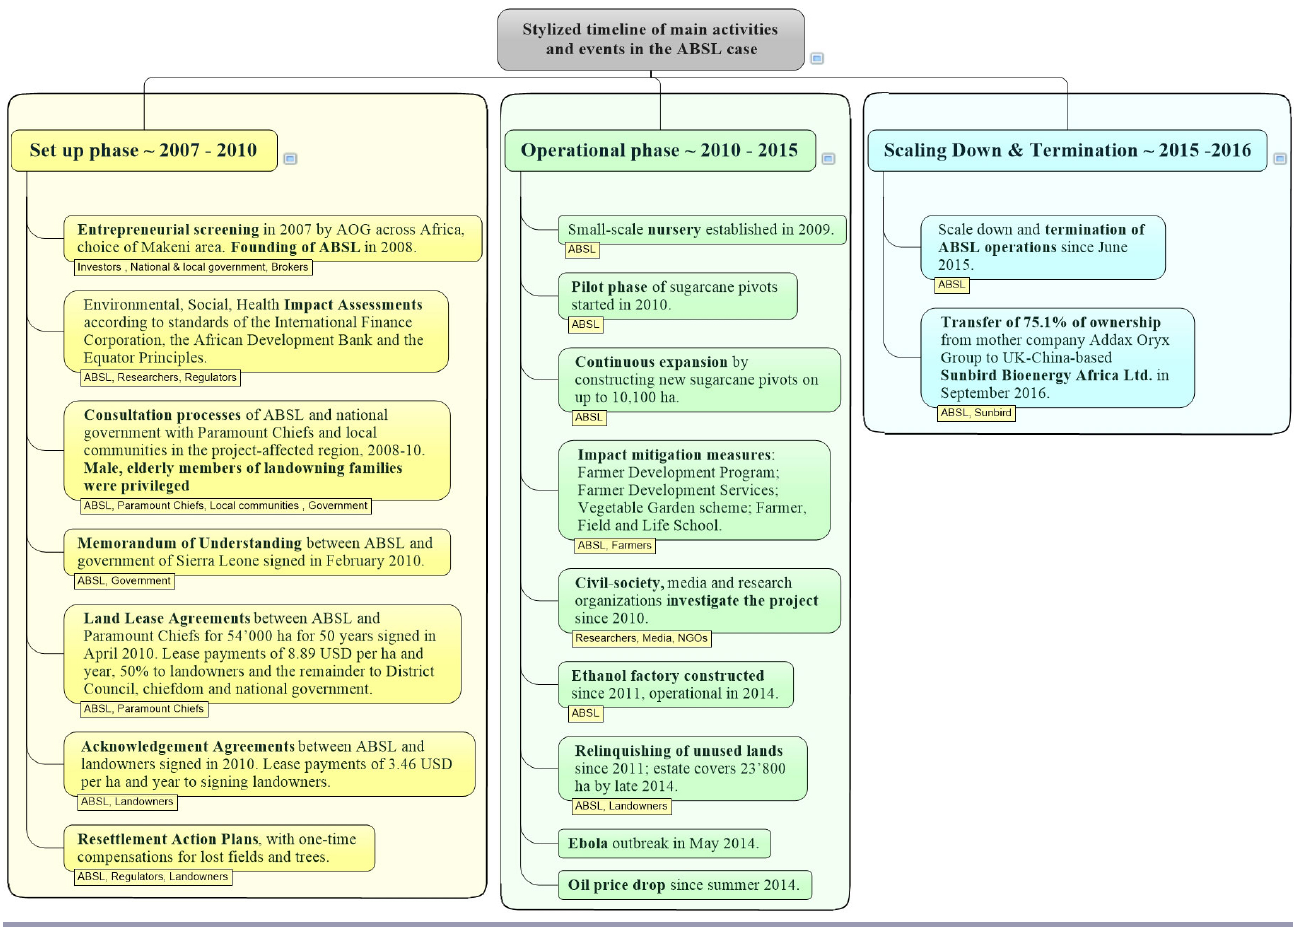
Fig. 3 . Stylized timeline of main activities and events in the Addax Bioenergy in Sierra Leone (ABSL) case. Sources: Manley et al. 2011, Bürgi 2015, Fielding et al. 2015, AOG 2016, Bottazzi et al. 2016, Marfurt et al. 2016, SiLNoRF and BfA 2016. Yellow boxes